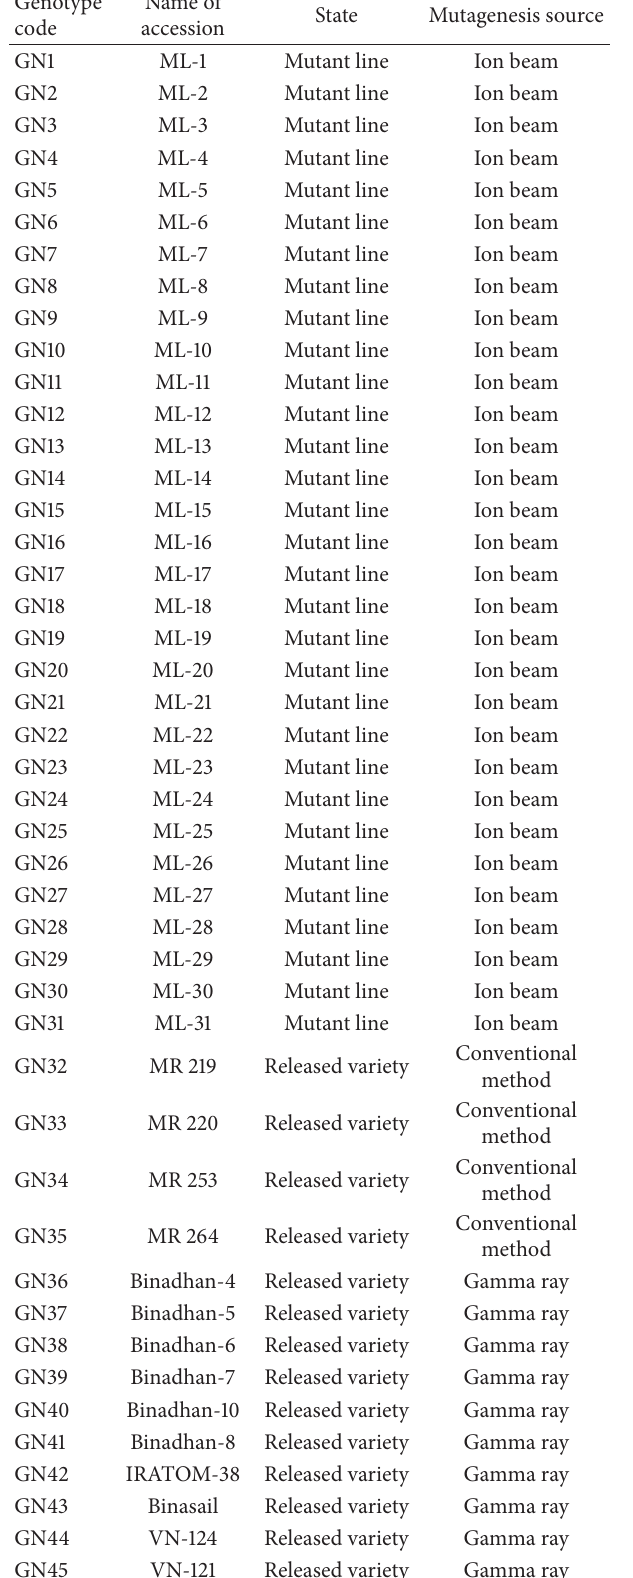
Table 1: List of rice genotypes